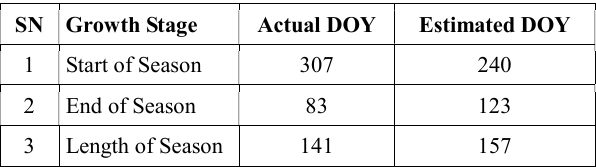
Table 1. Actual and estimated crop growth